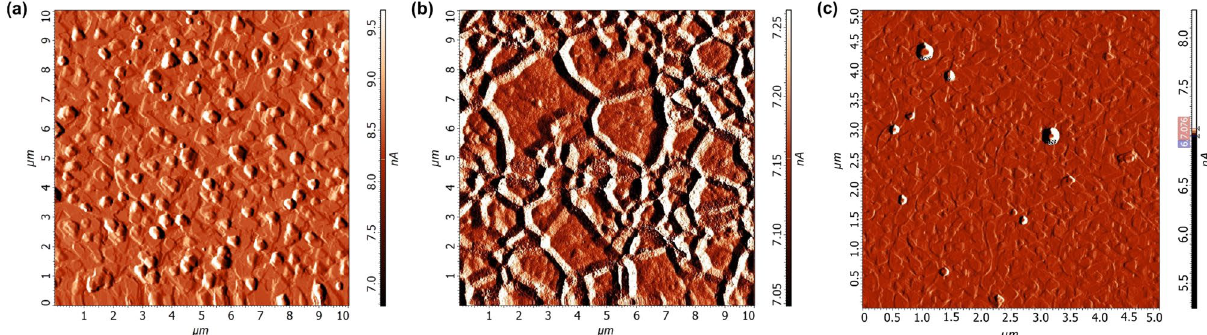
Figure 10. AFM-image of 120 nm Bi film surface before ( a ) and after ( b ) chemical etching. ( c ) AFM-image of 40 nm Bi film surface without chemical